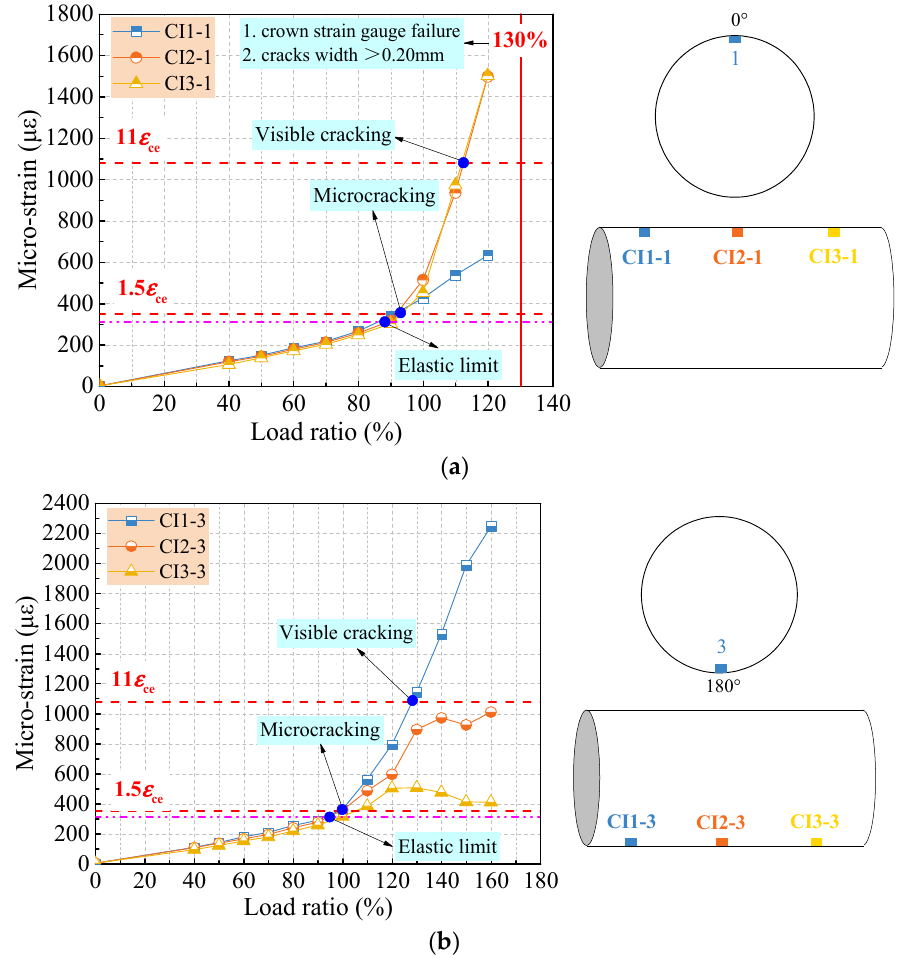
Figure 10. The load-strain relationships of the concrete at: ( a ) Crown (0°); ( b ) Invert (180°).